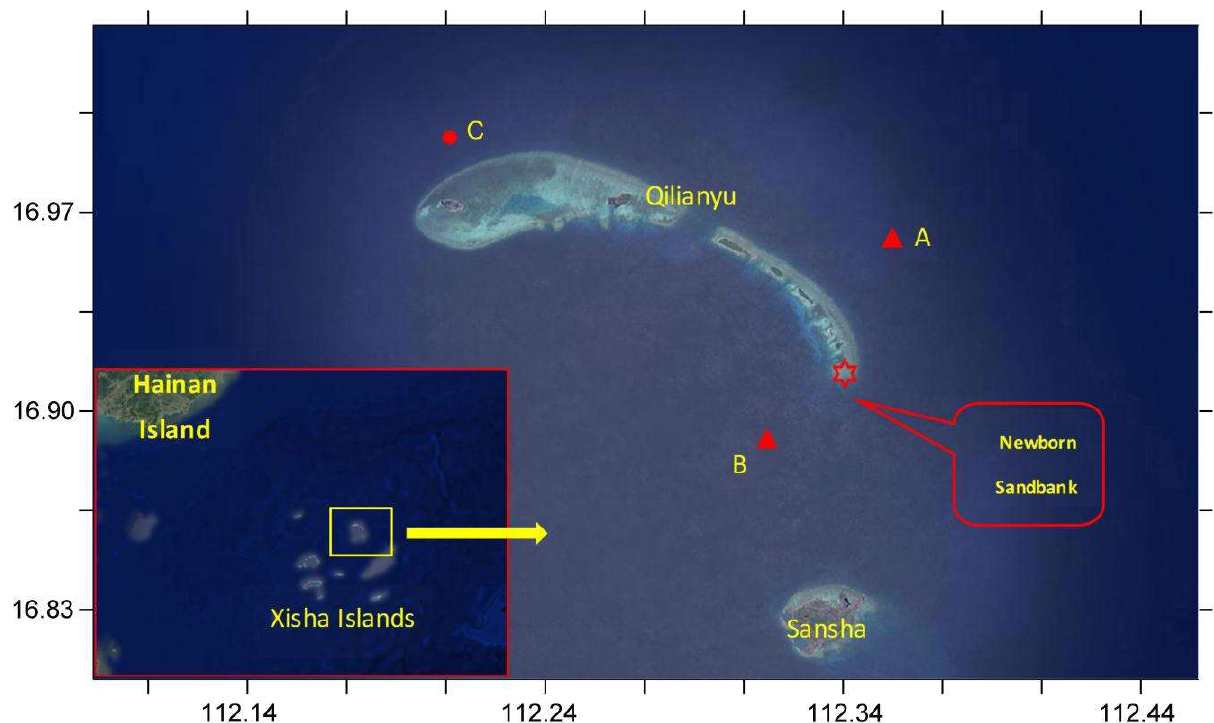
Figure 1. Scope of numerical model and location of a newborn sandbank in the Xisha Islands.